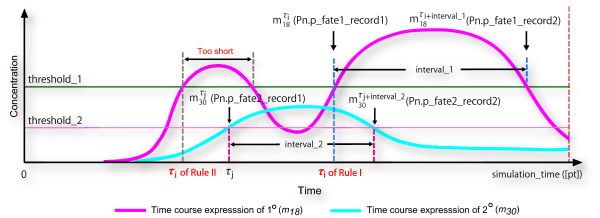
A schematized diagram depicting the fate specification methods by using Rule I and Rule II. "τi of Rule I" represents the first time epoch that the concentration of 1° (m18) exceeds threshold_1, and the time length interval_starting from "τi of Rule I" is longer than or equal to the given interval when using Rule I. "τj of Rule II" represents the first time epoch that the concentration of 1° exceeds threshold_1, no matter how long this interval will continue when using Rule II. τi represents the first time epoch that the concentration of 2° (m30) exceeds threshold_2. Variables m18 (denoting the concentration of 1°) and m30 (denoting the concentration of 1°) are regarded as two cell fate candidates for determining final VPC fate. Pn.p_fate1/2_record1/2 indicated in the brackets are the entity names used in Cell Illustrator.